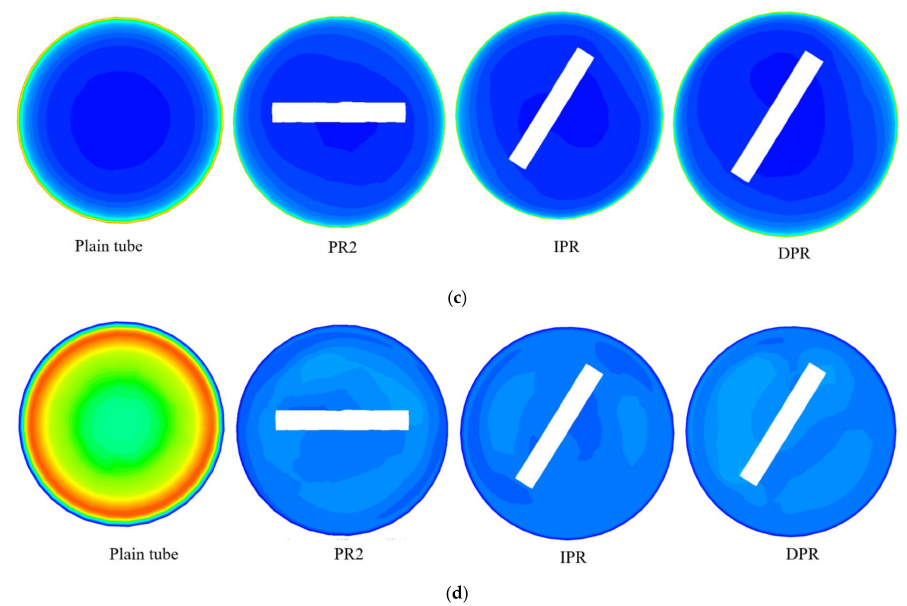
Figure 14. ( a ) The velocity streamlines, ( b ) velocity vectors, ( c ) temperature contours, and ( d ) turbulent kinetic energy of a nanofluid that is flowing inside a tube.